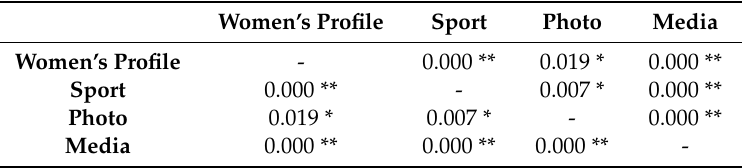
Table 8. p values corresponding to χ 2 Tests of Independence for the variables “profiles of women represented” (athlete or non-athlete), “photo” and